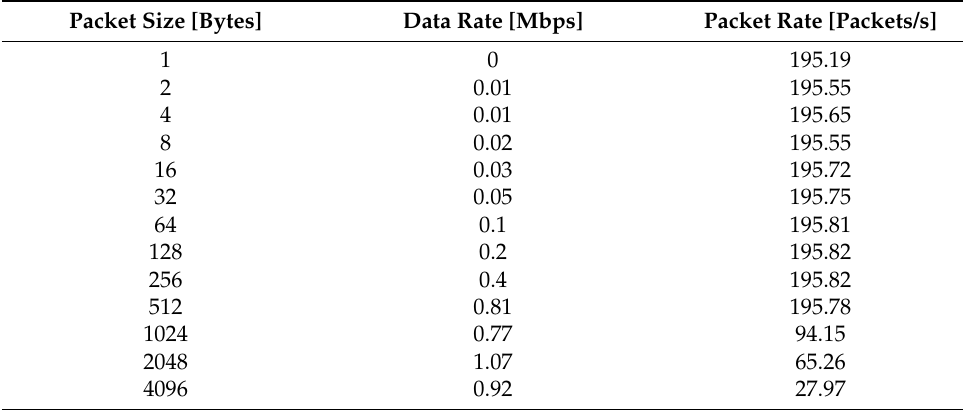
Table 5. WIC UWB node (PDHU) to WIC UWB GW (CDHU) maximum data